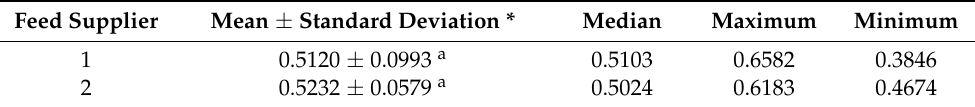
Table 2. Descriptive analysis of the water activity ( a w ) values obtained for feed samples for labora- tory animals. Feed Supplier Mean ± Standard Deviation * Median Maximum Minimum 1 0.5120 ± 0.0993 a 0.5103 0.6582 0.3846 2 0.5232 ± 0.0579 a 0.5024 0.6183